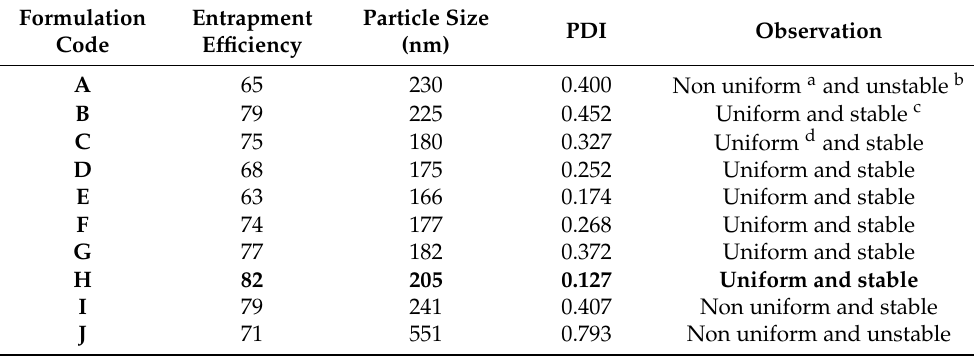
Table 2. Response parameters of formulation: entrapment efficiency, particle size and PDI.